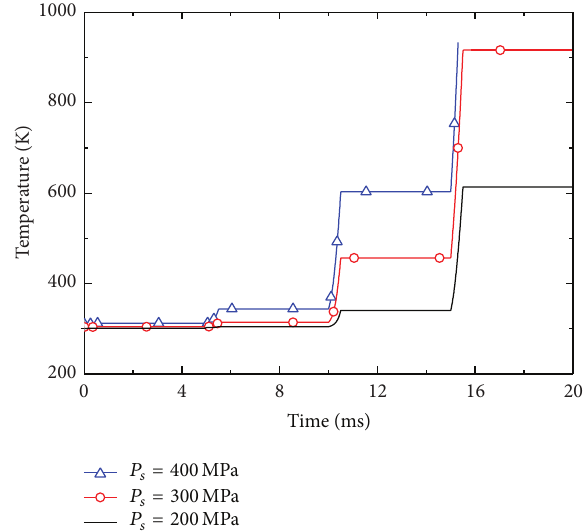
Figure 11: Temperature at pore surface when the explosive was loaded by four repeated pulses.